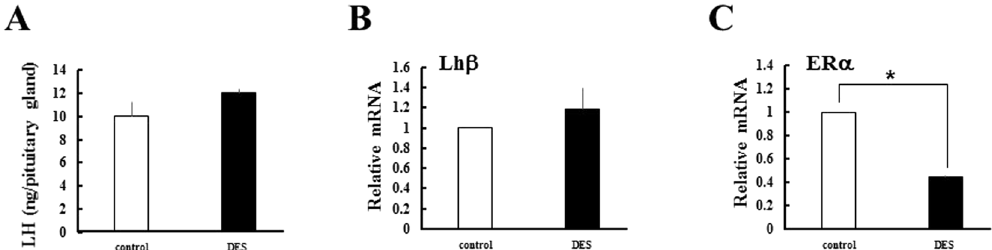
Figure 3. Effects of DES on pituitary LH content and gene expression. ( A ) Pituitary LH content in immature rats before and after 6 h treatment with DES. Data for each point are from three animals (the means ± SEM). Expression of pituitary Lh β ( B ) and ER α ( C ) in immature rats before and after 6 h treatment with DES. Expression of each gene was analyzed by Q-PCR and normalized to 36B4 expression. Q-PCR data represent the mean ± SEM of at least three independent samples. Differences between groups are indicated by * P <